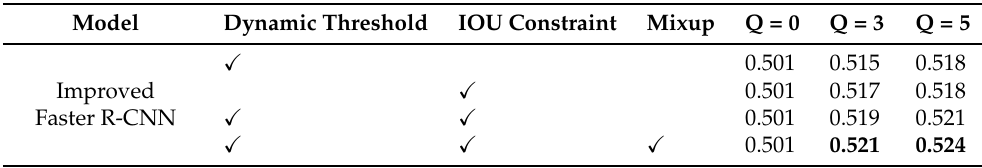
Table 6. Investigation of using different strategies in the self-training method.